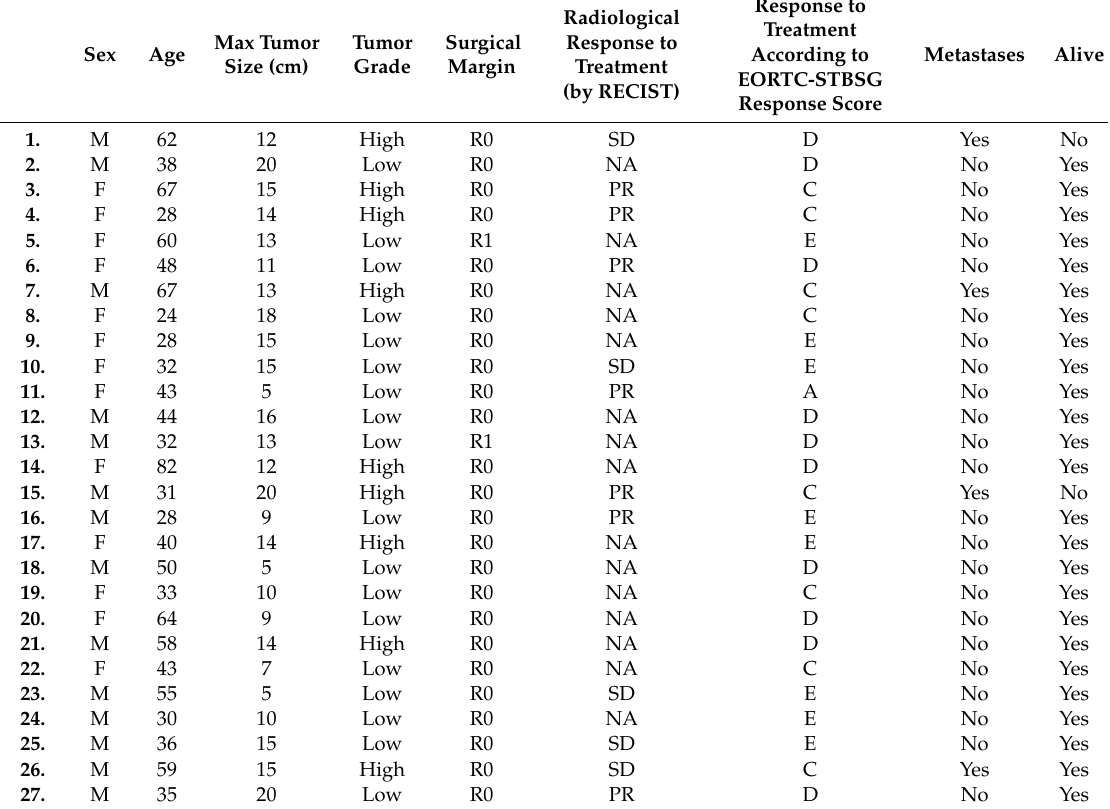
Table A1. Detailed characteristics of the